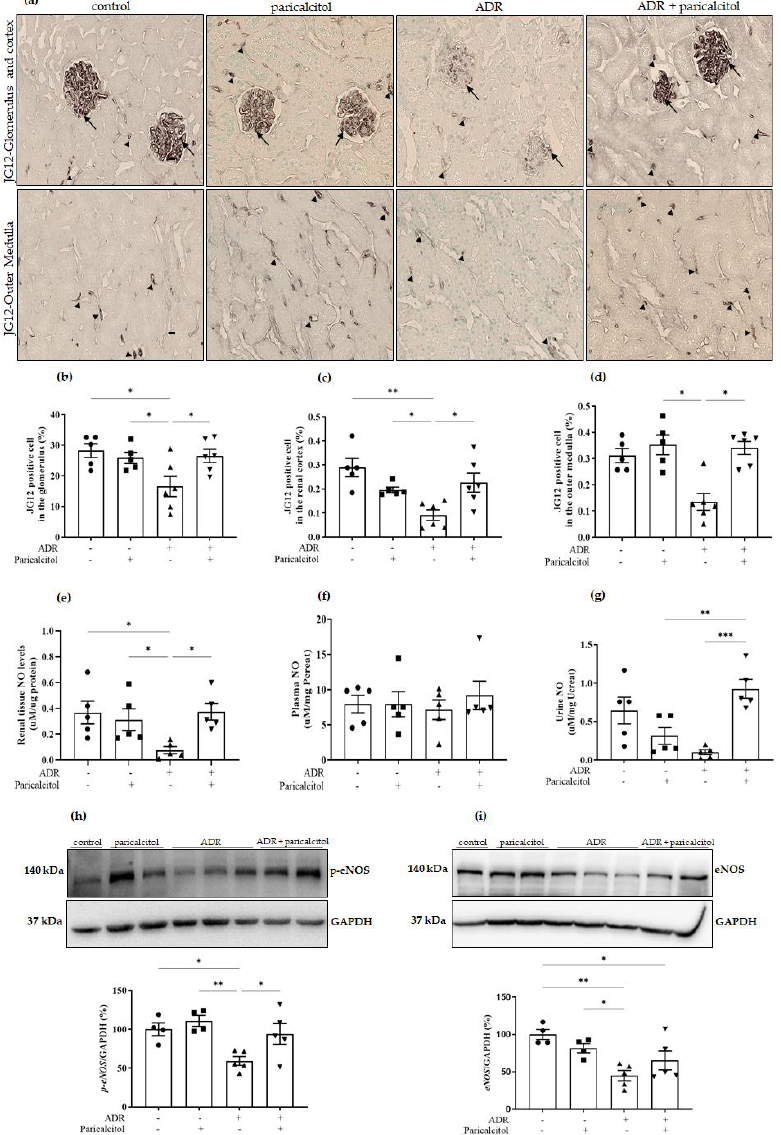
Figure 4. ( a ). The immunolocalization of JG12 in all renal compartments. The arrows indicate the JG12 − positive expression in the glomerulus. The arrowheads indicate the JG12 − positive expression in the tubulointerstitial compartments. ( b ). Percentual of JG12 − positive cells in the glomerulus. ( c ). Percentual of JG12 − positive cells in the renal cortex. ( d ). Percentual of JG12 − positive cells in the outer medulla. Immunohistochemical data are expressed as the mean ±SEM. Scale bar = 20 μm, n = 5 – 6 for each group. ( e ). Renal tissue NO levels. ( f ). Plasma NO. ( g ). Urine NO, n = 5 – 6 for each group. Densitometric ratios among ( h ) p − eNOS or ( i ) eNOS and GAPDH were calculated, and data were expressed compared with the control group. The control value was designated as 100%. Data are expressed as mean ± SEM. n = 4 – 5 for each group. Data from the control (dots), paricalcitol (squares), ADR (up triangles), and ADR + paricalcitol (down triangles) groups. * P < 0.05; ** p < 0.01; *** p < 0.001. Pcreat . Plasma creatinine; Ucreat . Urine creatinine.